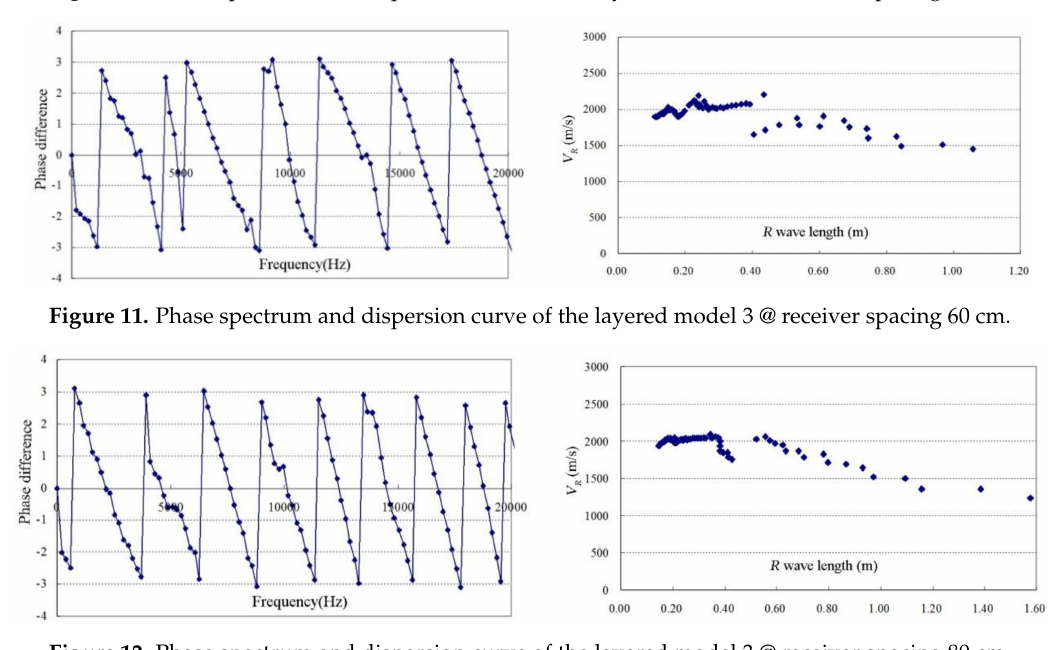
Figure 10. Phase spectrum and dispersion curve of the layered model 3 @ receiver spacing 20 cm.